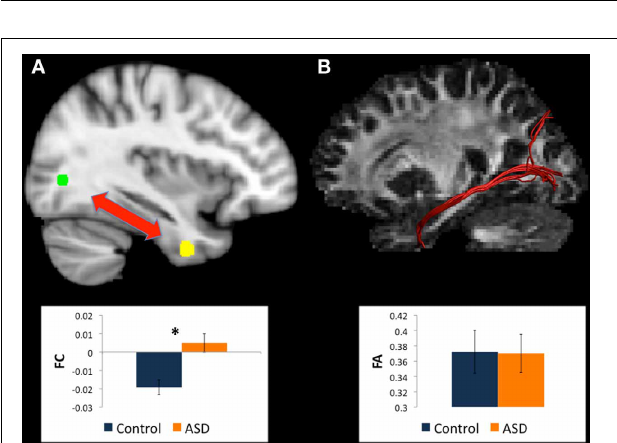
FIGURE 4 | (A) Regions for tractography in left BA19 (green sphere) and left cuneus (yellow sphere). The ASD group showed weaker functional connectivity relative to controls between these regions during a mental rotation task. The bar graph shows the strength of functional connectivity (FC) in the Control group (blue) and ASD group (orange) between these regions. (B) Example of white matter tracts that directly connect the left BA19 and left cuneus regions in one participant. The bar graph shows Fractional Anisotropy (FA) in the Control group (blue) and ASD group (orange) in these white matter tracts. ∗ indicates statistical significance with p < 0 . 05.